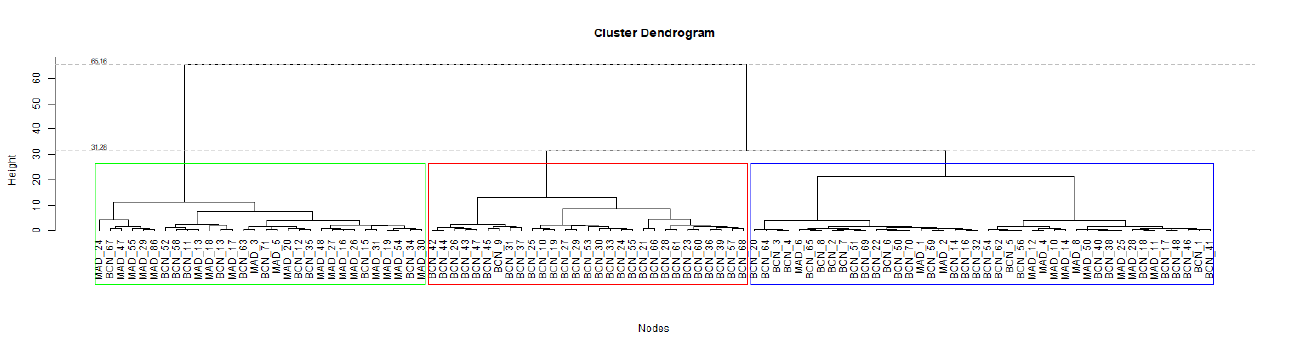
Figure 2. Nodes distribution within clusters by distance for k = 3 Hierarchical Agglomeration clustering. abbreviations: MAD X Madrid Stations, BCN X Barcelona Stations. Clusters groups are colored as presented in Table